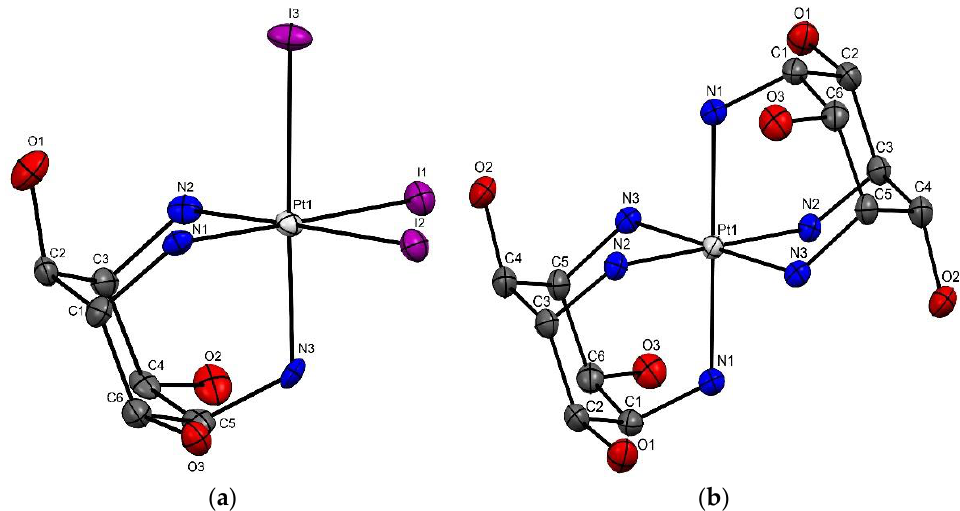
Figure 1. The conformation and atom numbering scheme in the complex cations: ( a ) [PtI 3 (taci)] + , 1 ; ( b ) [Pt(taci) 2 ] 4+ , 2 . The thermal displacement ellipsoids at a 30% probability level are used for non-H-atoms. H-atoms are omitted for clarity.